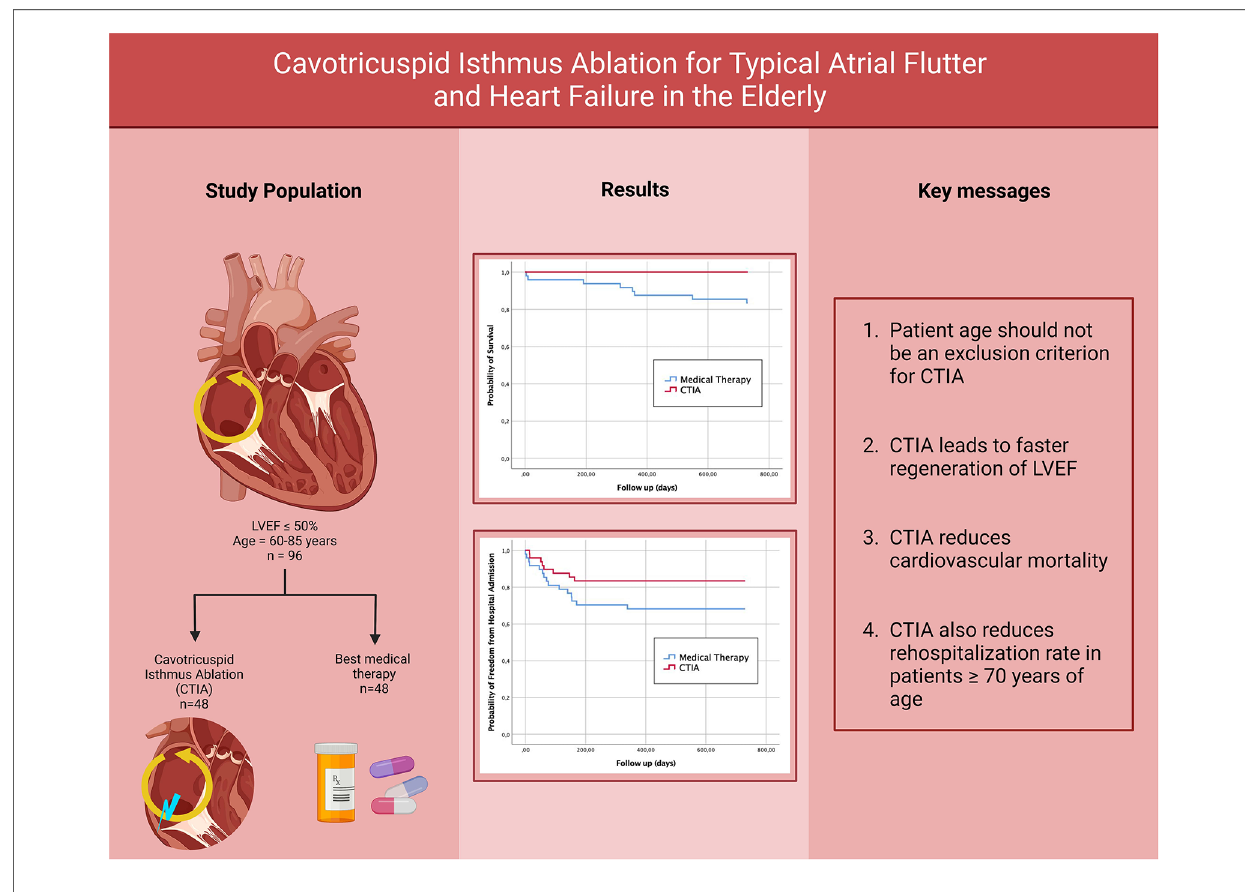
FIGURE 8 Graphical abstract of the study (created with